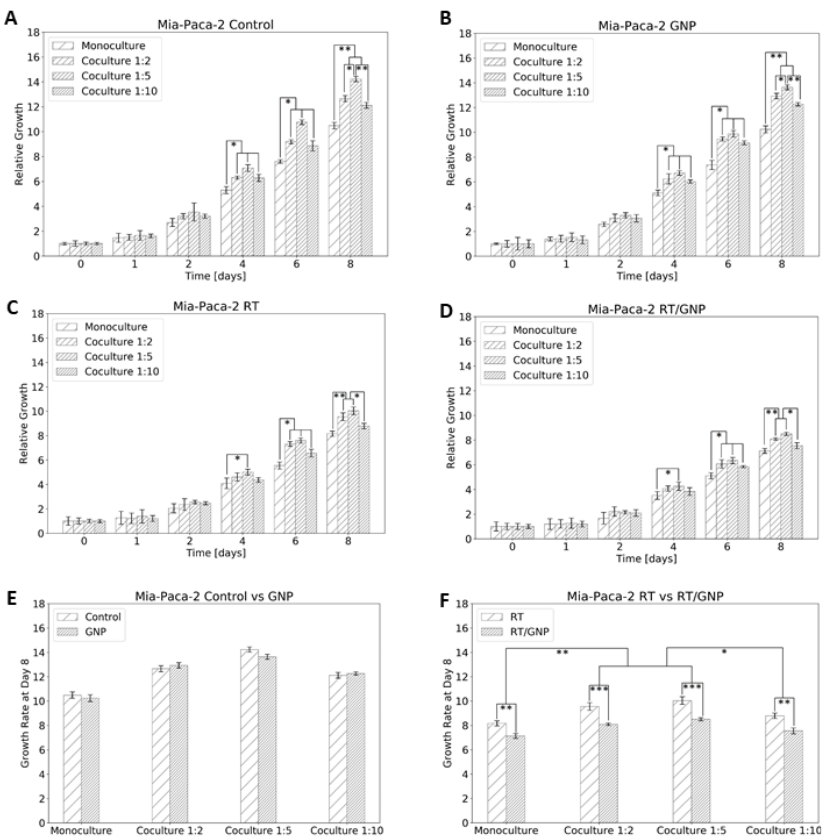
Figure 7. Proliferation assay for Mia-Paca-2. ( A ) Control cells. ( B ) Dosed with GNP. ( C ) Irradiated 2 Gy. ( D ) Dosed with GNP and irradiated 2 Gy. ( E ) Comparison of control vs. GNP at the end of the experiment. ( F ) Comparison of RT vs. RT/GNP at the end of the experiment. * indicates p < 0.05, ** indicates p < 0.01, *** indicates p < 0.001.